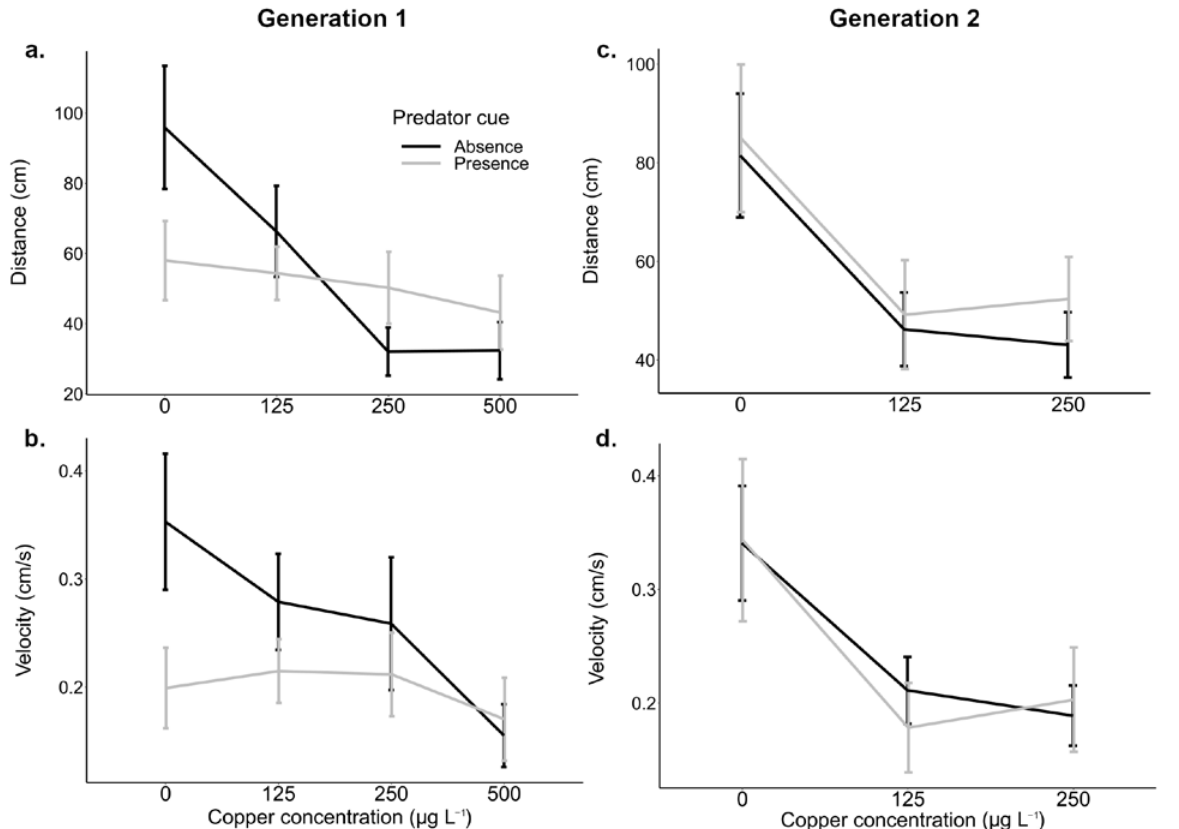
Figure 1. Effects of predation cues and copper concentration exposures on distance and velocity of movements by two generations of Culex pipiens larvae. Panels ( a , c ) are mean distances for the first and second generations, ( b , d ) are mean velocities; bars are standard errors. Connecting lines are included as a visual aid only.